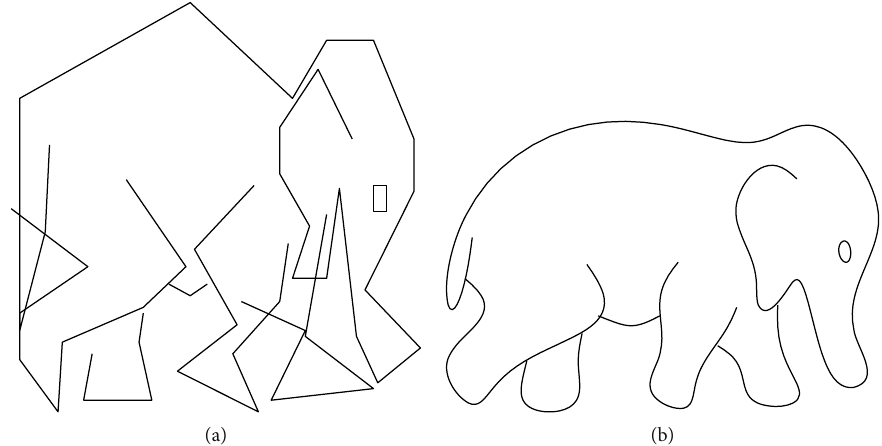
Figure 4: Application of R